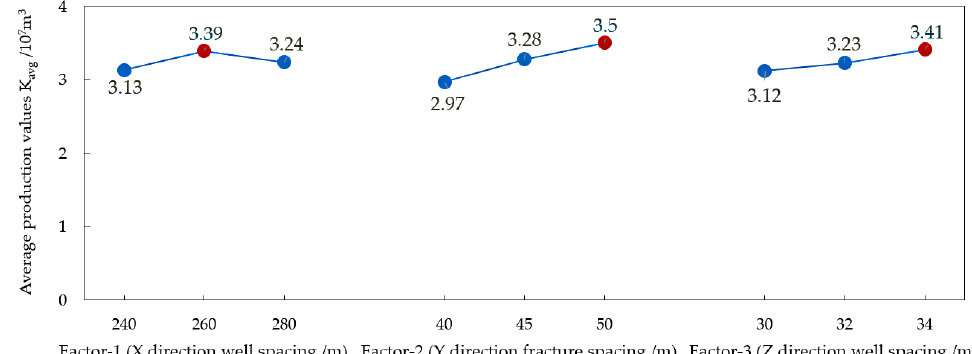
Figure 12. Average production values of three levels in the three factors of horizontal well.